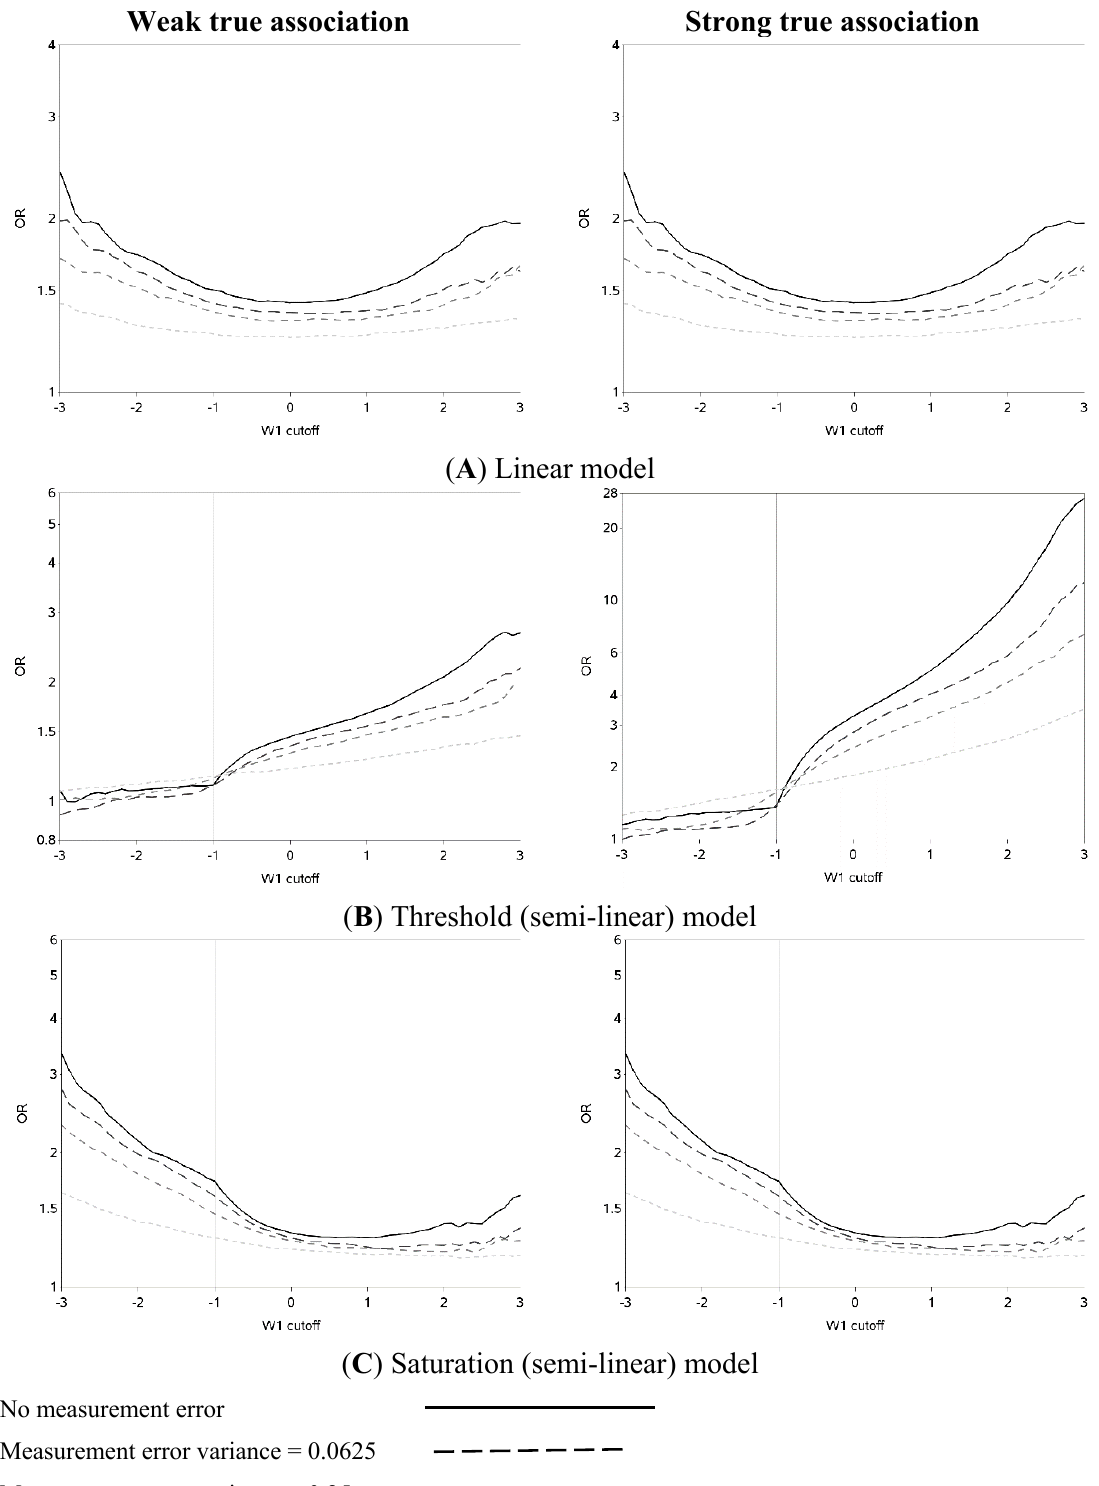
Figure 2. Odds ratios (ORs) for different cutoffs (between mean ± 3 standard deviations) used to dichotomize a mismeasured exposure (W 1